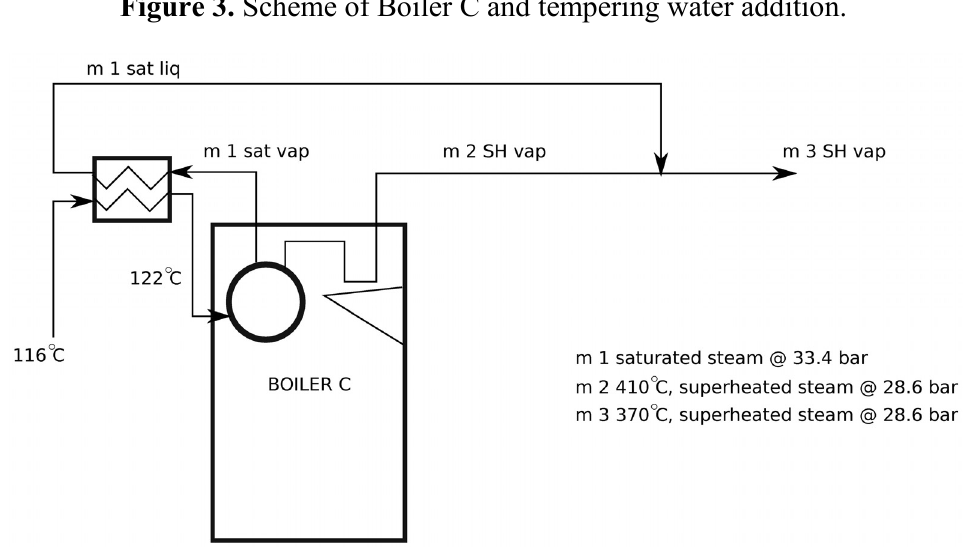
Figure 3. Scheme of Boiler C and tempering water